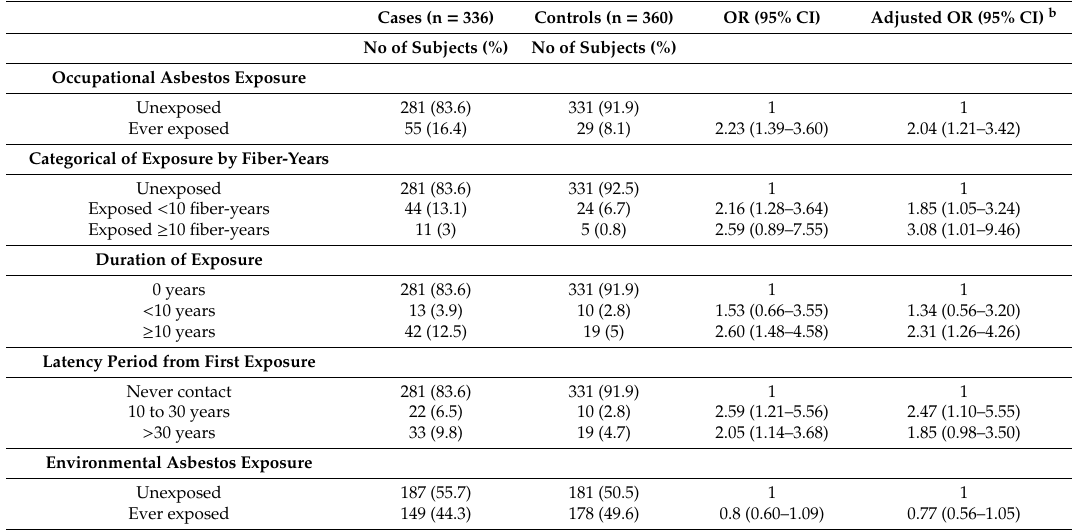
Table 5. Odds ratio and adjusted odds ratio of the association between asbestos exposure and lung